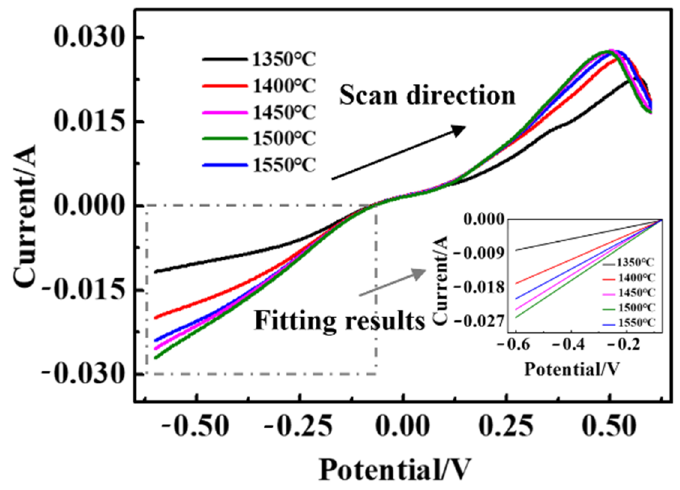
Figure 8. LSV curves of the Pt/YSZ